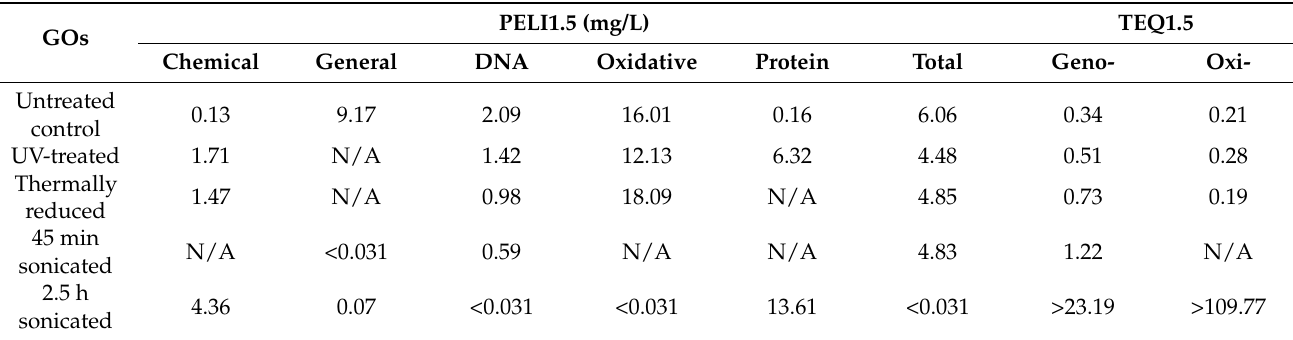
Table 2. Summary of PELI-based molecular endpoint PELI1.5 (mg/L) and toxic equivalents geno-TEQ1.5 and oxi-TEQ1.5. PELI1.5 was determined from the four-parameter logistic (4PL) nonlinear concentration-response curves (SI Figure S3) at the studied concentration range for the 5 stress and total categories. Toxic equivalents geno-TEQ1.5 and oxi-TEQ1.5 are for genotoxicity and oxidative stress, respectively, induced by each GO at PELI1.5, using mitomycin C (MMC) and H2O2 as the reference compounds,